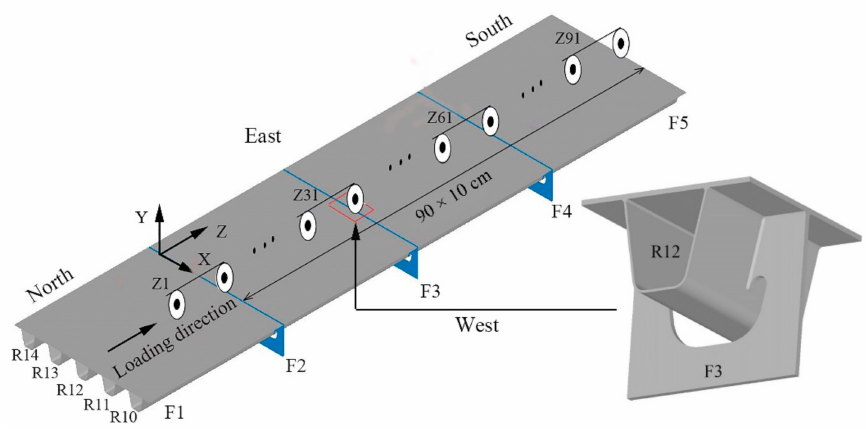
Figure 13. Finite element model of the OSD